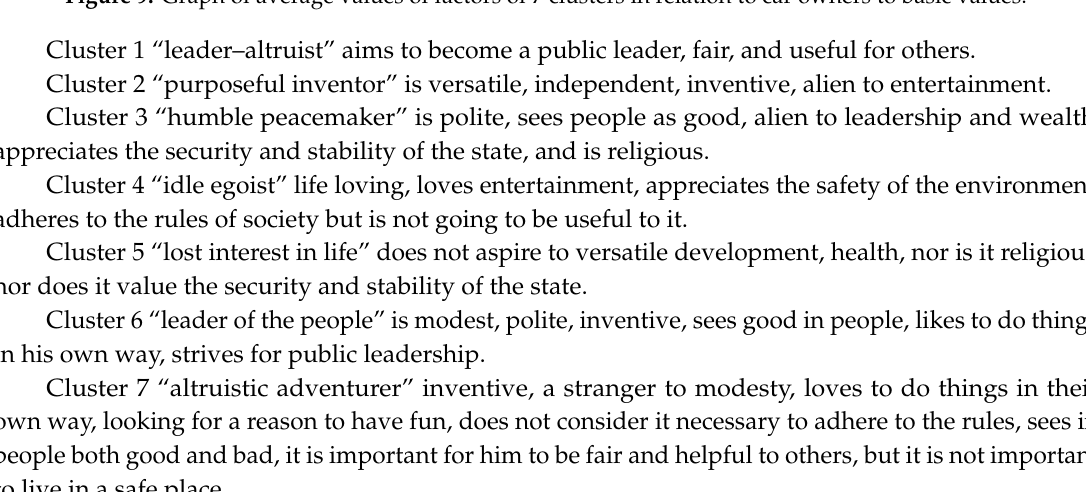
Figure 9. Graph of average values of factors of 7 clusters in relation to car owners to basic values.